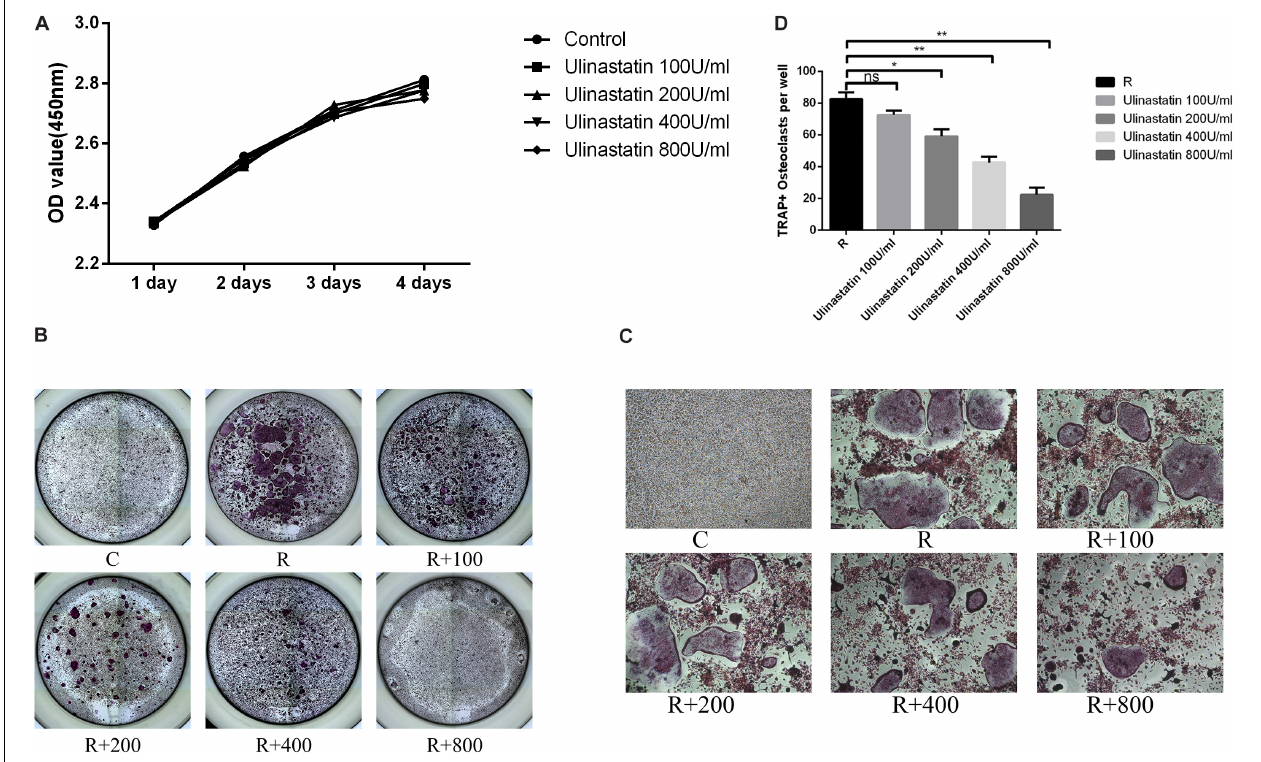
FIGURE 3 | Ulinastatin inhibits RANKL-induced osteoclastogenesis. C represents control group, R represents RANKL group, R + 100 ∼ 800 represents RANKL + 100 units/mL ulinastatin ∼ RANKL + 800 units/mL ulinastatin group. (A) Ulinastatin barely has influence on survival and proliferation of BMMs. BMMs (1 × 10 4 cells/well) were cultured with M-CSF (30 ng/mL) and five different concentrations of ulinastatin (0, 100, 200, 400 and 800 units/mL) for 4 days. Data are presented as mean ± SD of three independent experiments. (B,C) Ulinastatin prevents the formation of osteoclasts in a dose-dependent manner. BMMs (1.0 × 10 4 cells/well) were cultured with M-CSF (30 ng/mL), RANKL (100 ng/mL) and four different concentrations of ulinastatin (100, 200, 300 and 400 units/mL) for 5 days. The cells were stained for TRAP assay. (D) TRAP-positive multinucleated osteoclasts ( ≥ 3 nuclei) were quantified. Data are presented as means ± SD of three independent experiments. ∗ P < 0.05 and ∗∗ P <